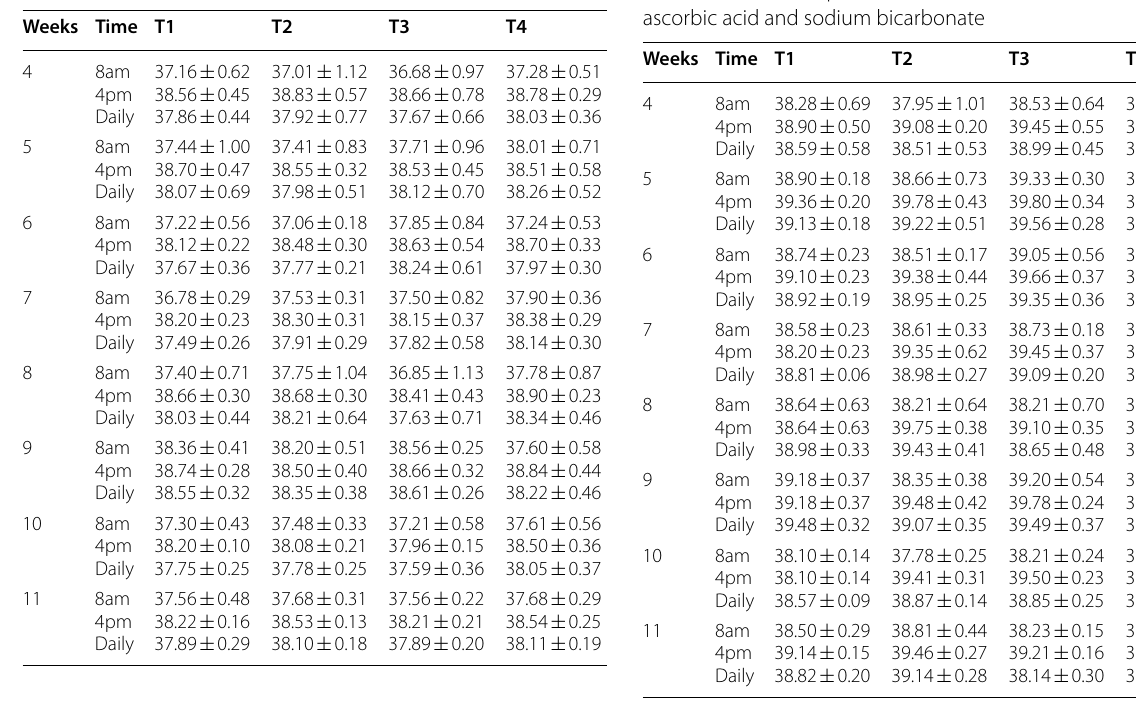
sodium bicarbonate +